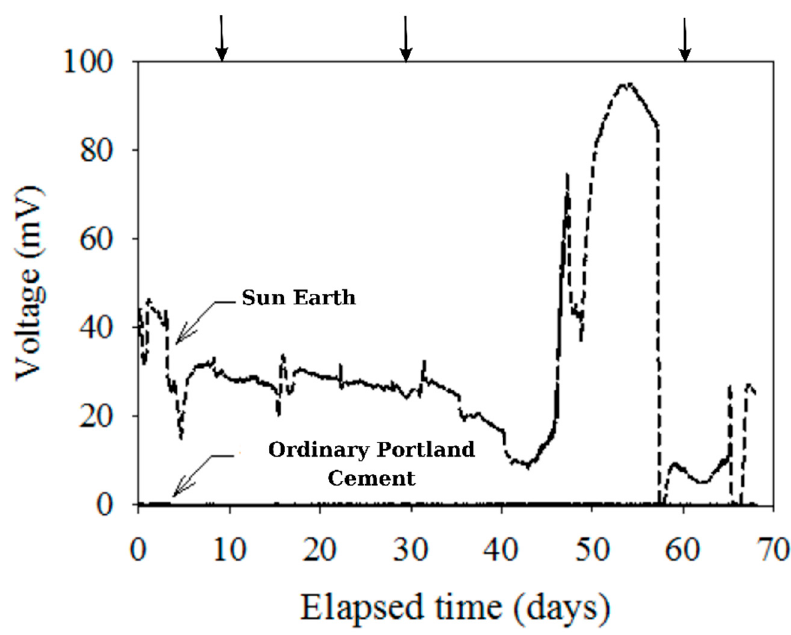
Figure 6. Experimental results of voltage measurement by time. Arrow ( ↓ ) indicates the addition of glucose (100 mg/L) and magnesium sulfate (33 mg S/L).